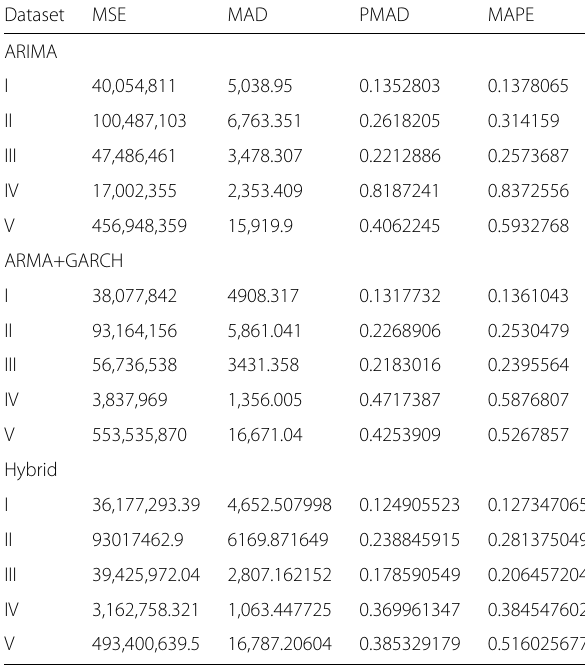
Table 4 Prediction accuracy of the selected model with respect to each